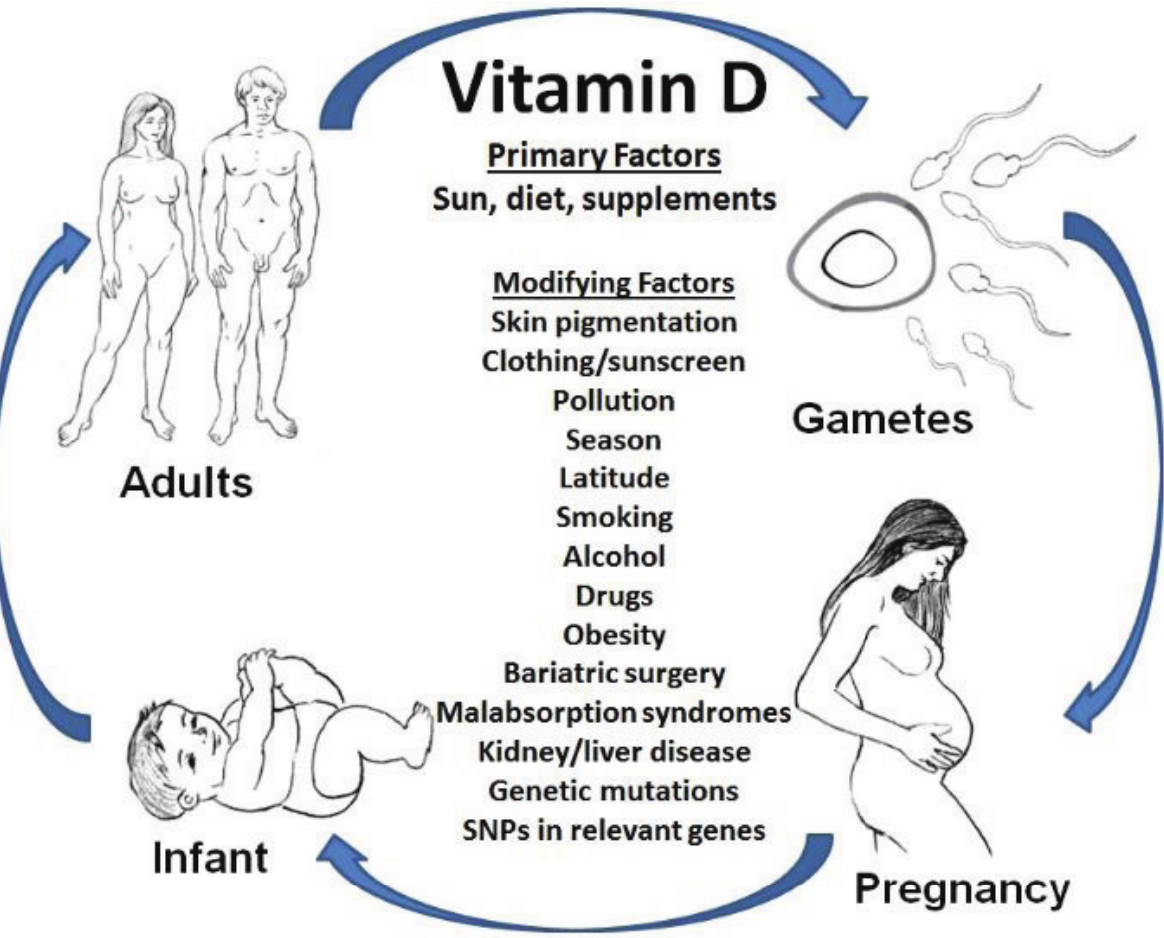
Figure 1. Modifying factors that can affect vitamin D status throughout the life